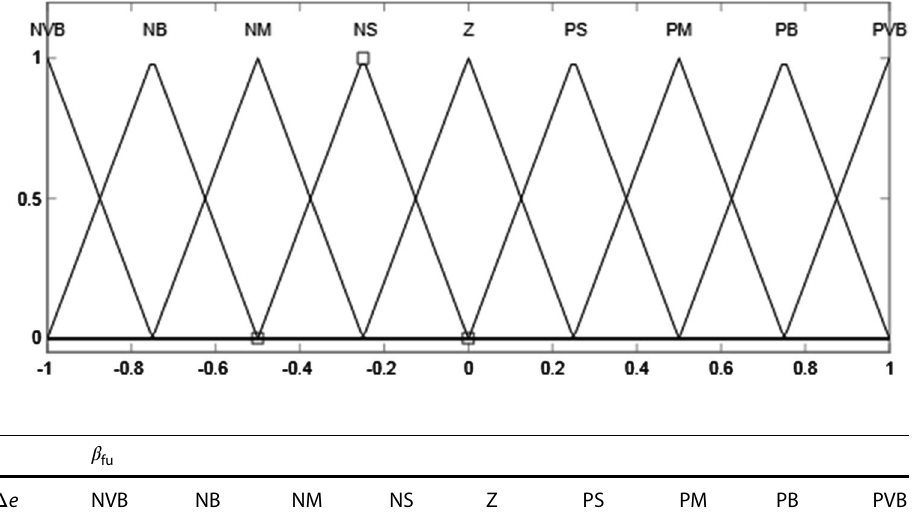
Fig. 3 9 MFs for input variable ( Δ e ) and output variable ( 𝛽 fu )